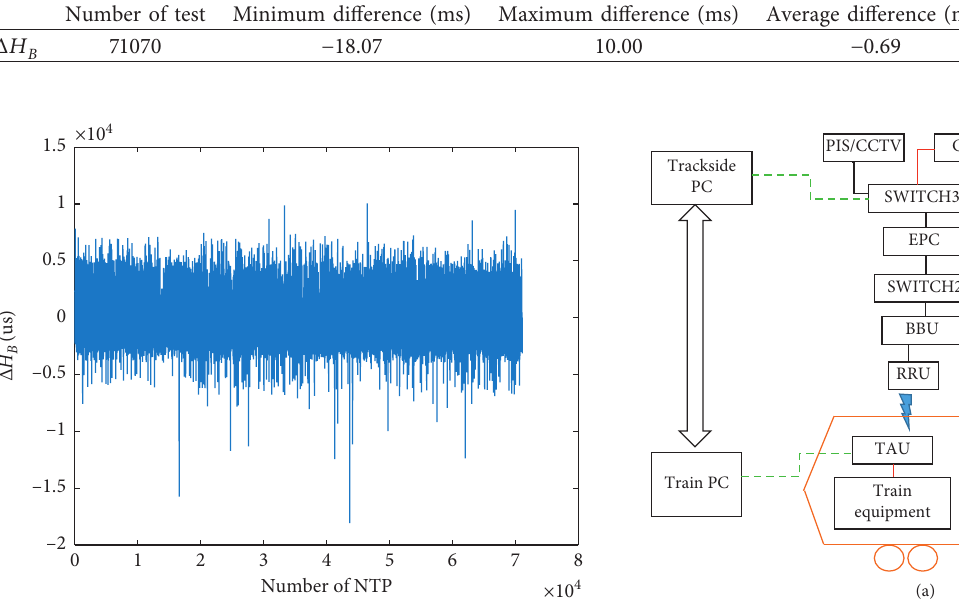
Figure 7: (a) LTE-M system structure. (b) Actual test B .